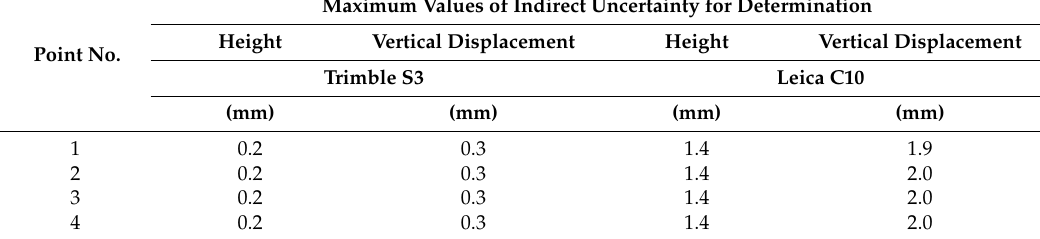
Table 4. The maximum values of the indirect uncertainty for the determination of the heights and vertical